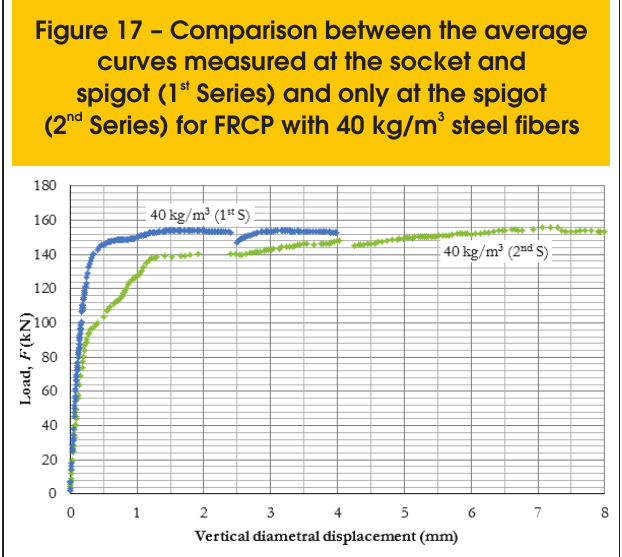
Figure 17 – Comparison between the average curves measured at the socket and st spigot (1 Series) and only at the spigot nd 3 (2 Series) for FRCP with 40 kg/m steel